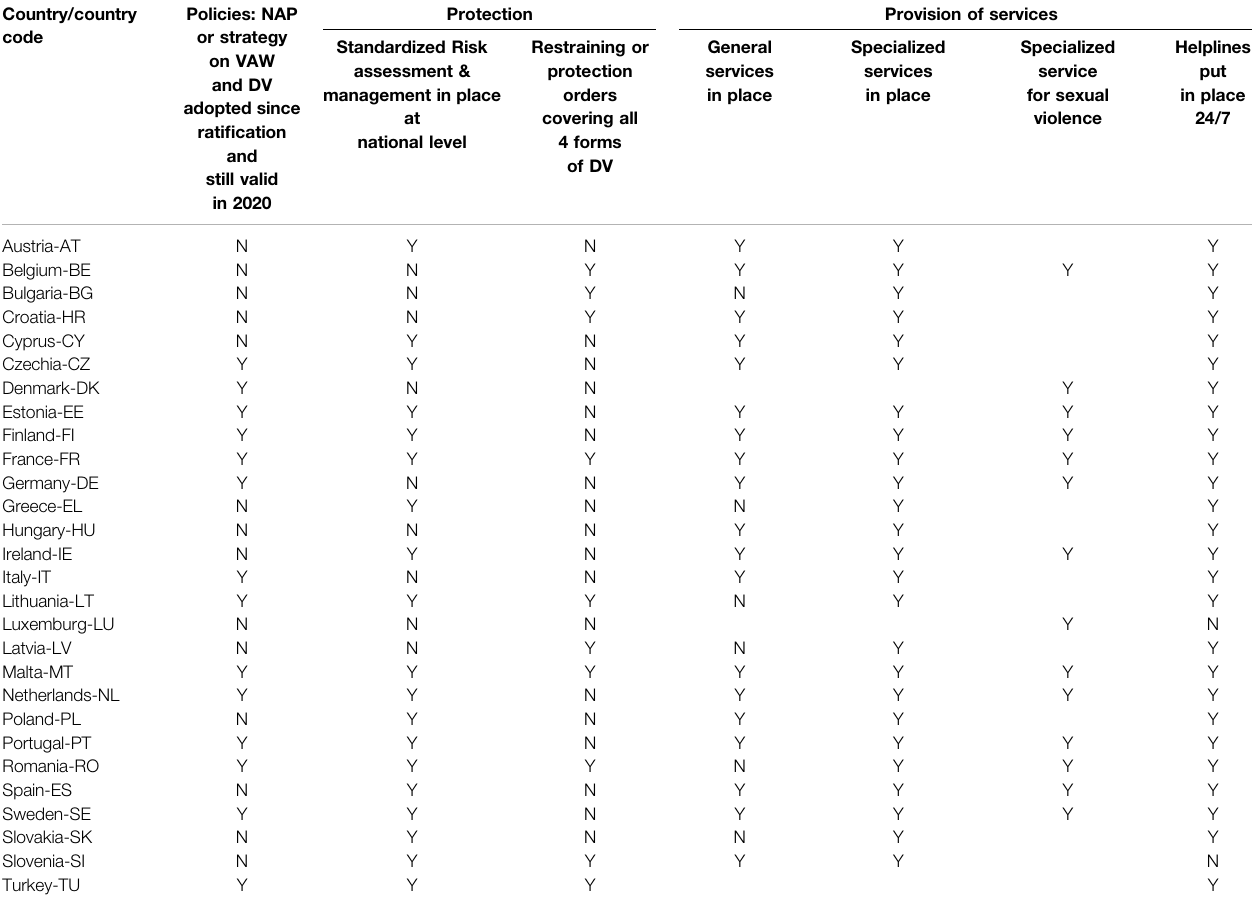
TABLE 3 | Overview Integrated Policies, Protection and Provision of services. Country/country